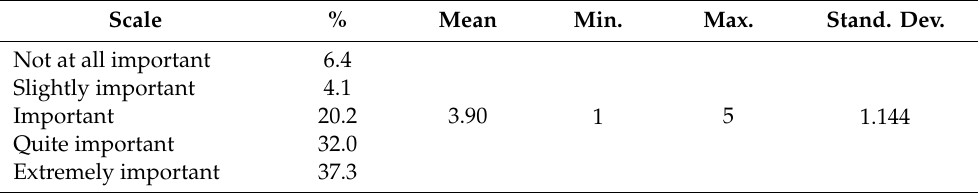
Table 6. Gastronomic motivation.